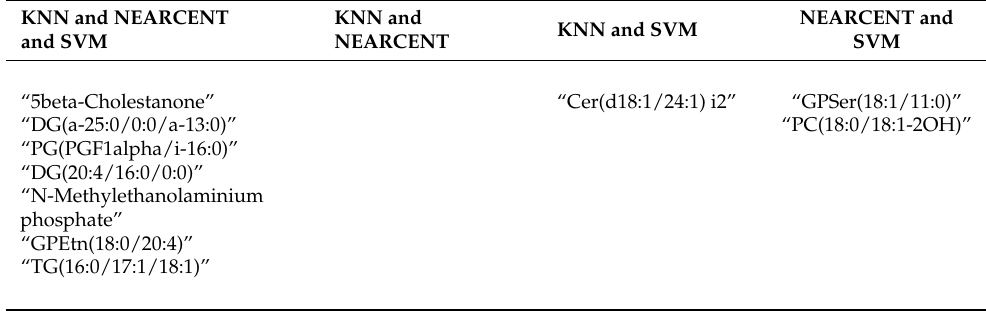
Table 15. Common metabolites found in each model for Diabetes-Nephropathy. KNN and NEARCENT and SVM KNN and NEARCENT KNN and SVM